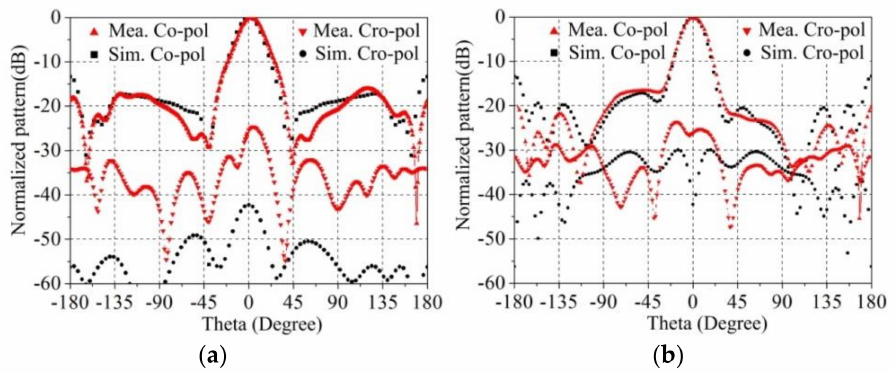
Figure 13. Simulated and measured radiation patterns (dB) of ( a ) E plane and ( b ) H plane at 2.45 GHz.